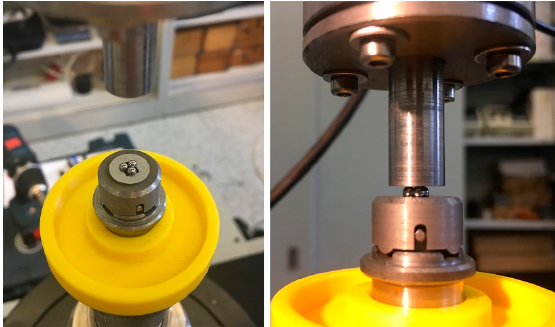
Figure 3. The test setup used for the measurements of the bi-axial flexural strength via B3B.